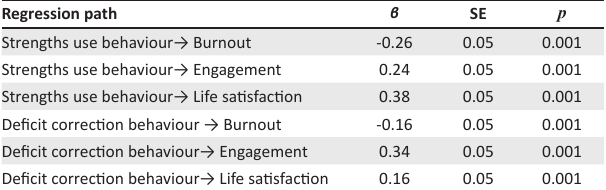
TABLE 5: Regression results for the structural model.